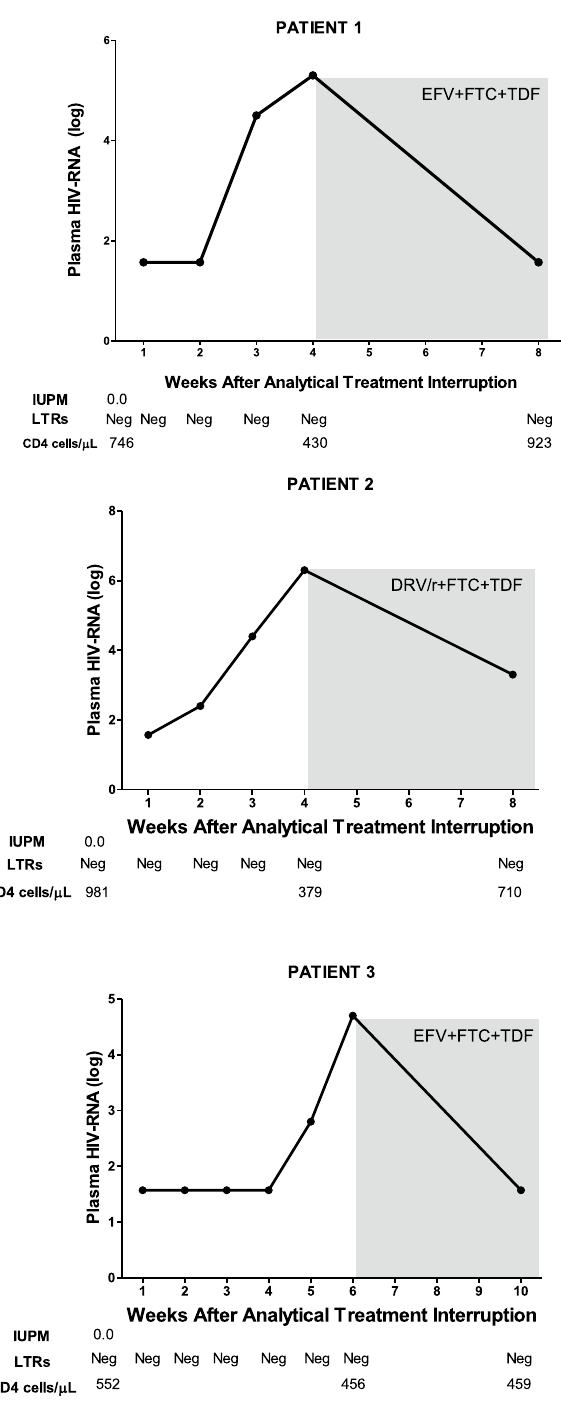
Figure 2. Virologic evolution of HIV rebounded in the maraviroc-treated patients who underwent into the analytical treatment interruption shown in terms of conventional viral load (log plasma HIV RNA), infections units per million cells (IUPM), episomal two LTR-DNA circles (2LTRs), and total CD4 T cell count (CD4 cells/ µL). Measurements for each parameter were done at the indicated time. The grey shaded box shows the time on ART restart. EFV, efavirenz; FTC, emtricitabine; TDF, tenofovir; DRV/r, ritonavir-boosted